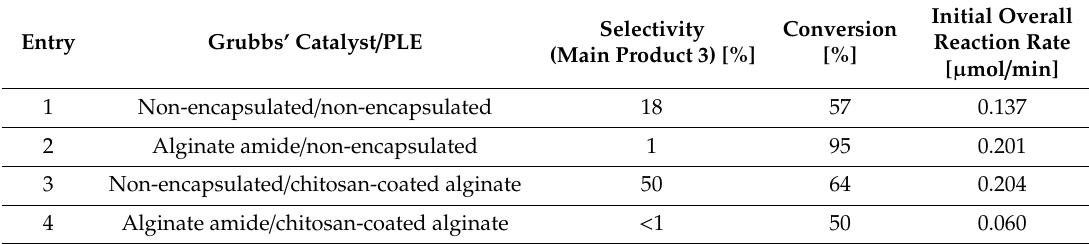
Table 1. Encapsulating the catalysts in separate beads influenced the